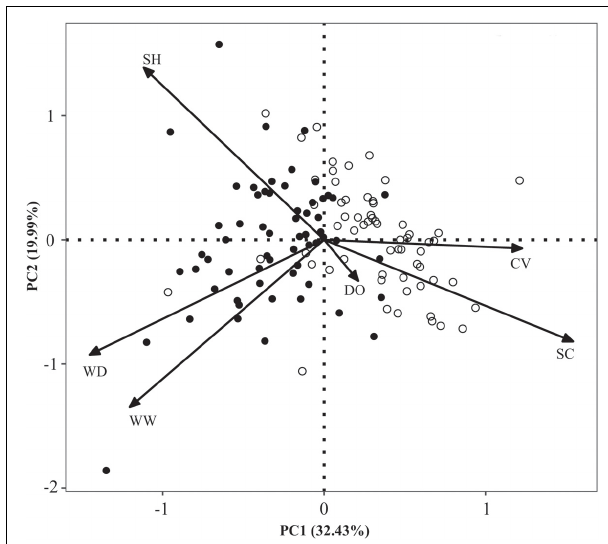
FIGURE 3 | Ordination plots of the principal component analysis (PCA) between impoundments and reference free-flowing segments. Solid and hollow circles represent the impoundments and free-flowing segments, respectively. WW, wetted width; WD, water depth; SH, substrate heterogeneity; SC, substrate coarseness; DO, dissolved oxygen; and CV, current